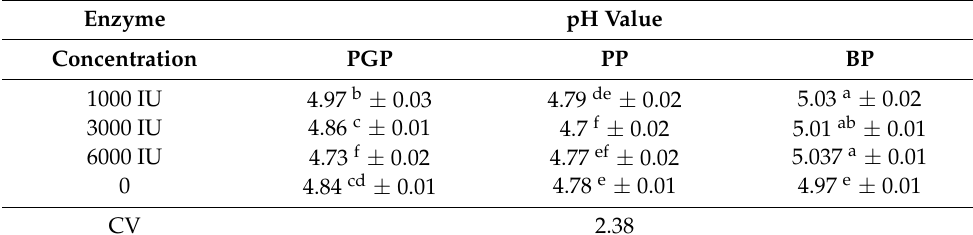
Table 2. The pH values of fermented fruit peel extracts.